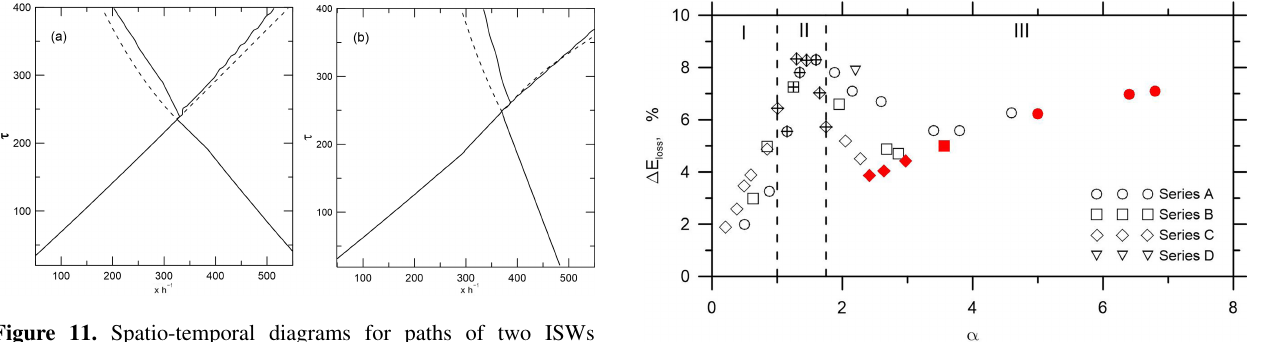
Figure 12. Plot of the energy loss versus the amplitude of the equal colliding waves. The filled symbols correspond to the cases with KH instability. The crossed symbols correspond to the cases where colliding waves lost trapped cores in the process of